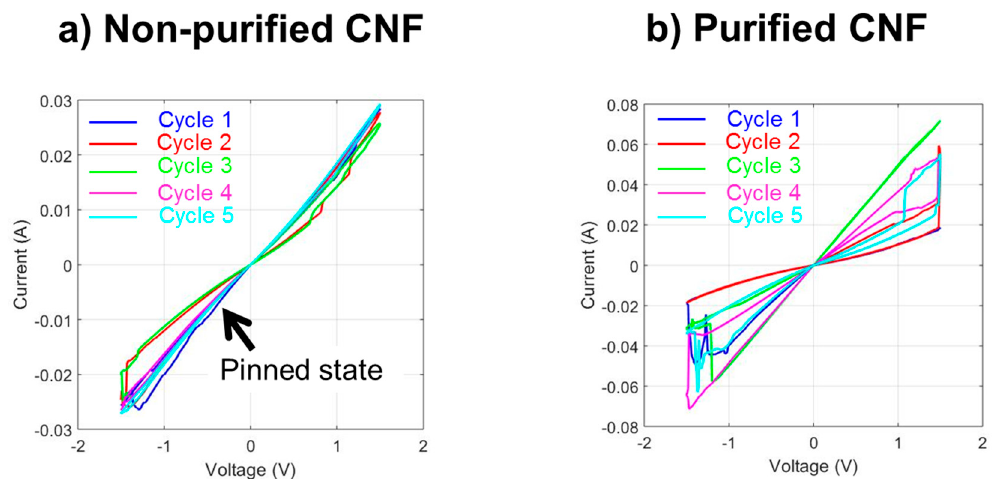
Figure 7. ( a ) Non-purified carbon nanofibers (CNFs) lead to memories being pinned in one state after a few cycles. ( b ) A memory fabricated with purified CNFs withstands many cycles without being pinned in one state.